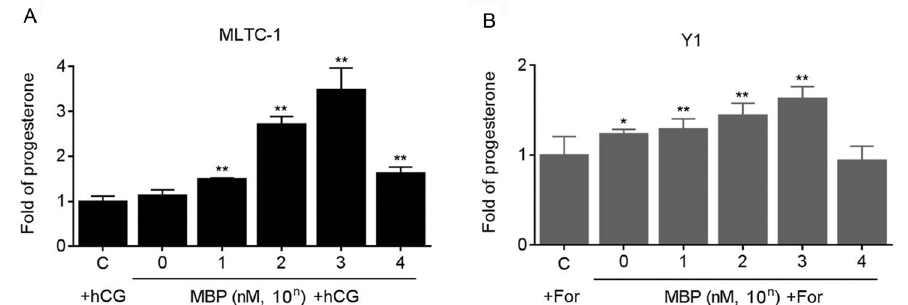
Fig 1. Effects of MBP on the progesterone secretion. (A) MLTC-1 and (B) Y1 cells were exposed to 0 ~ 10 4 nM MBP in the presence of 100 U/L hCG or 10 μ M forskolin for 24 h respectively, the secretion of progesterone was determined in triplicate. The amounts of progesterone measured in control cells were MLTC-1: 8.85 ± 0.21 ng/ml, Y1:8.01 ± 0.32 ng/ml, respectively. * p < 0.05 and ** p < 0.01 compared with cells exposed to hCG or forskolin alone.